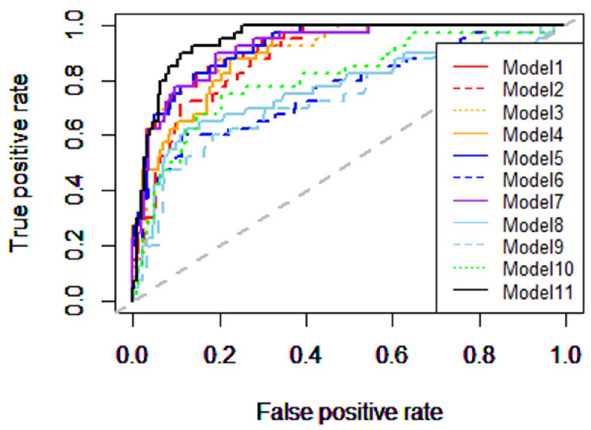
Figure 6. The AUROC values of each of the 11 models in Table 3. The Models 1–6 is the SVM applying two TEPS indices, the model 7 applied all 4 TEPS indices, the model 8–9 applied the conventional indices, and the model 11 used all 6 variables. Analysis was conducted in R (R Core Team 2014) and figures were produced using the package ROCR 35 .